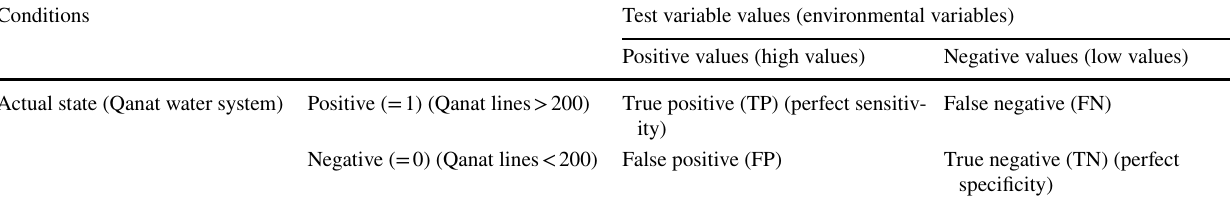
Table 3 Confusion matrix of the study based on the major hydrological basins Conditions